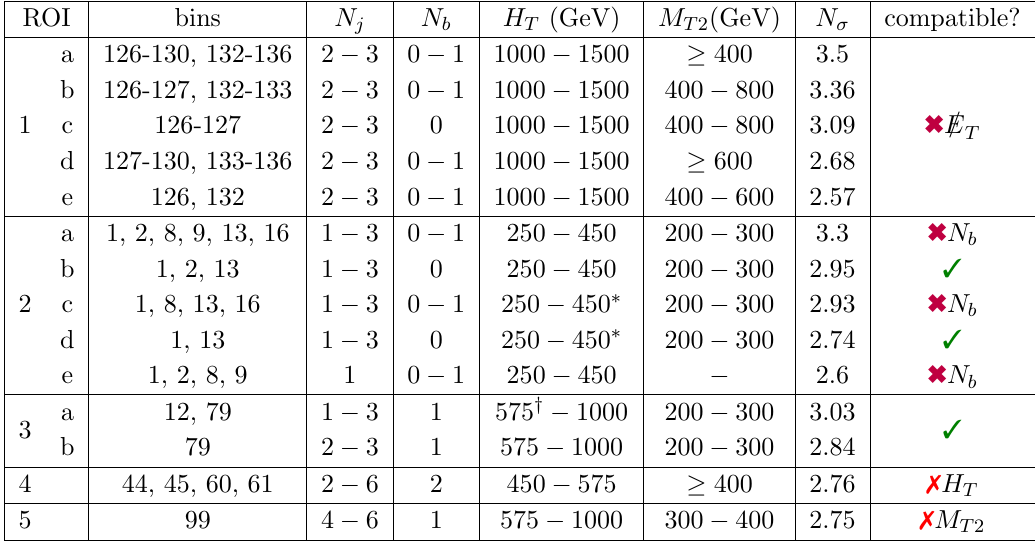
Table 1 . The aggregated regions in CMS036 [12] with the highest local discrepancy between the data and the background. We group signi(cid:12)cant subsets and overlapping aggregations into ROIs in this table. The asterisk (*) in the H T columns marks a requirement that do not apply to all the aggregated bins, in particular bins 1 and 8 have only H T < 350 GeV. Similarly, the dagger ( y ) denotes that bin 12 has H T > 700 GeV. Also note that the M T 2 requirement does not apply to N j = 1 bins. We mark the compatibility of each excess by 3 (if compatible), 7 (if not compatible with nearby SRs in the same search) and 6 (if incompatible with other searches). In case of incompatibility, we list the kinematic variable responsible.